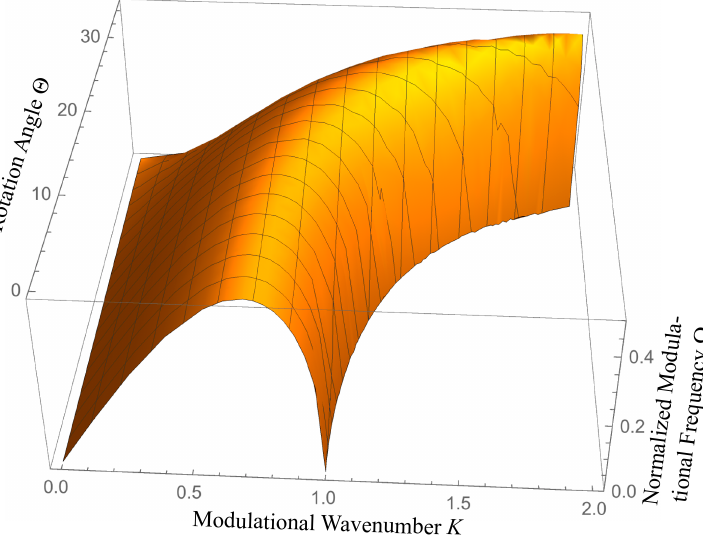
Figure 12. Instability diagram surface for the rotated 1 + 1 NLS equation as a function of the modulational wavenumber and the rotation angle.